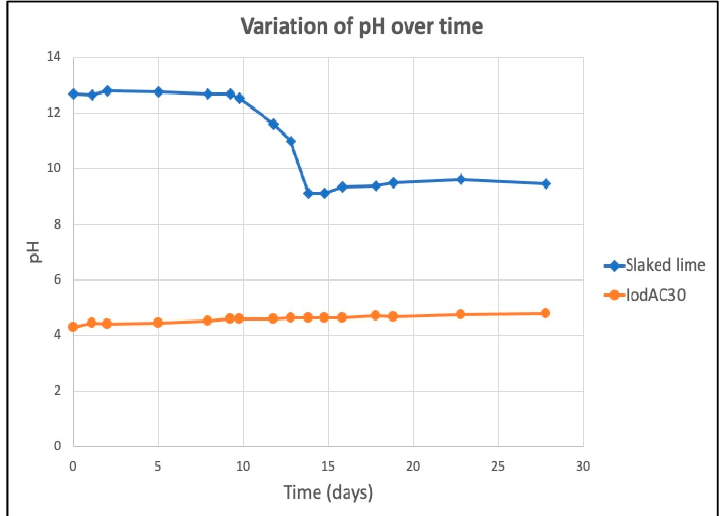
Figure 10. IodAC vs. slaked lime: variation of pH.